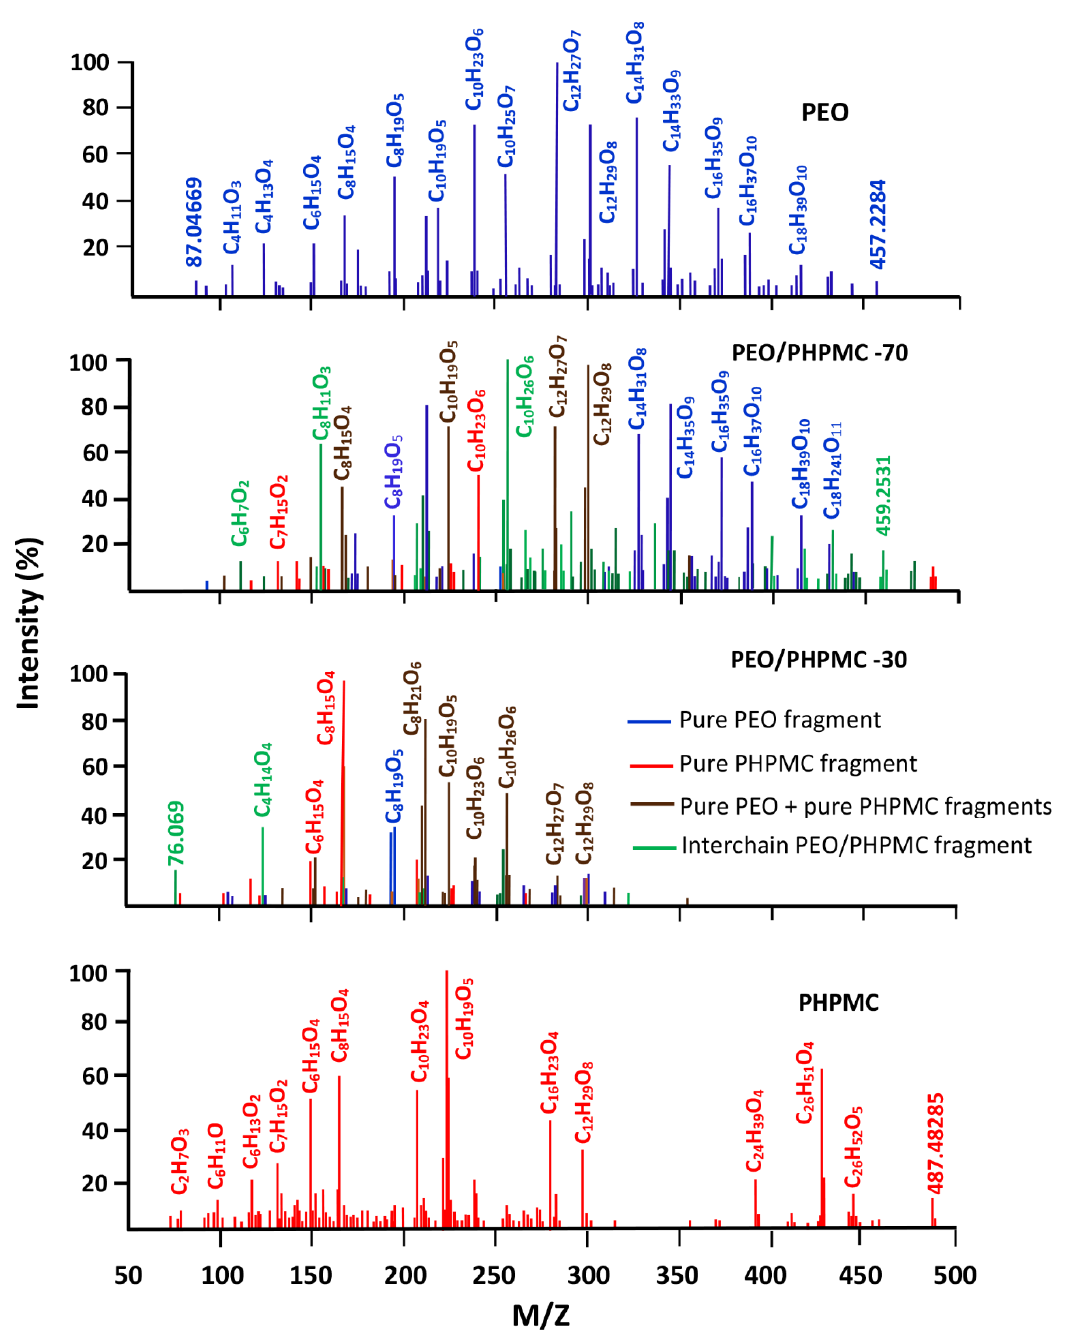
Figure 14. Comparative spectra of pure PEO, PHPMC, and their blend with 30 wt% and 70 wt% of PEO.